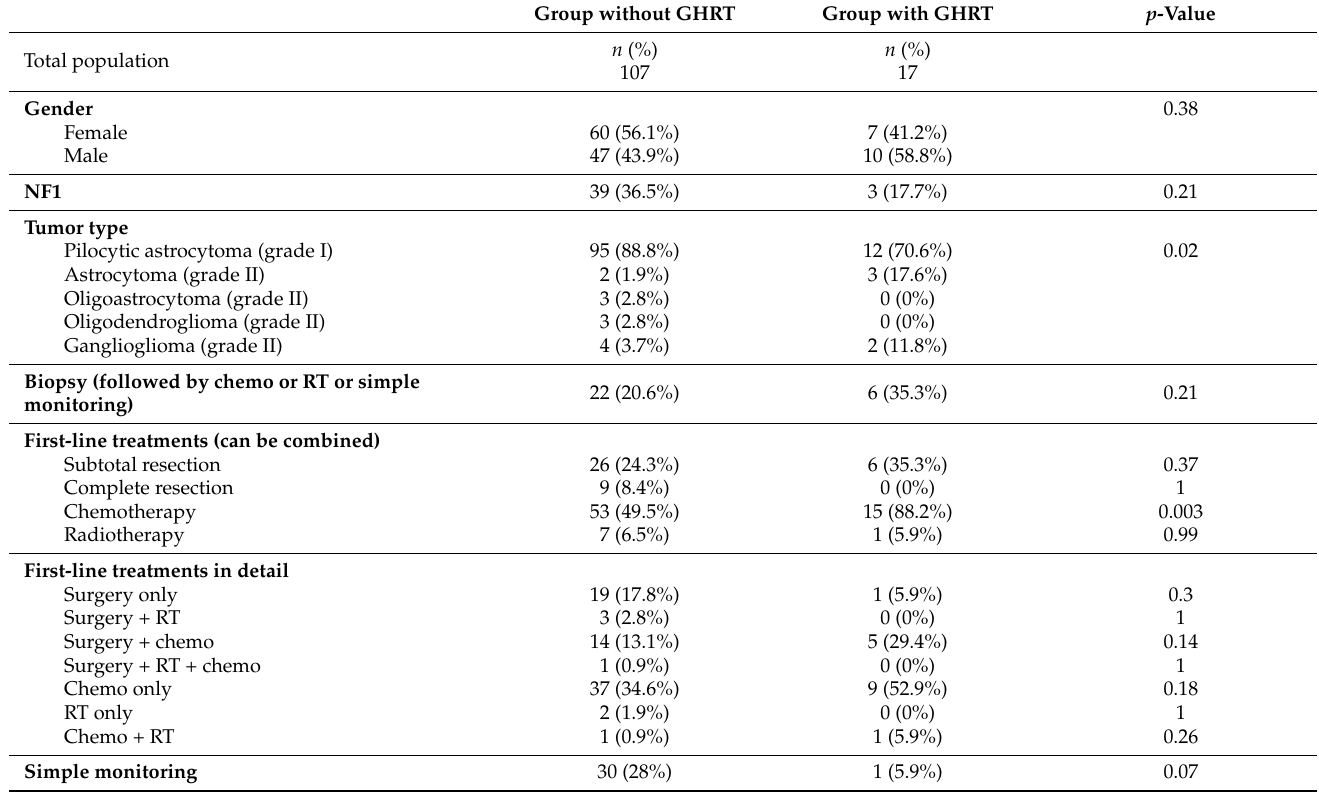
Table 1. Population characteristics.